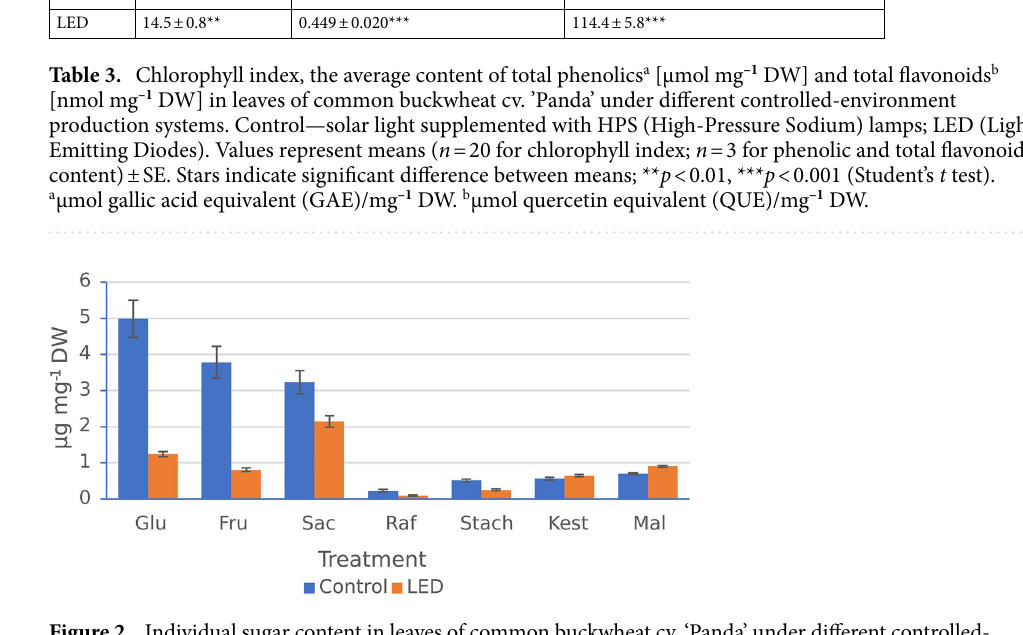
sugars were significantly lower in the plants grown under LED, except for kestose and maltose. The highest dif- ferences were found for glucose (its amount was four times lower), fructose (five times lower), and sucrose (one and half times lower compared to that of the control).